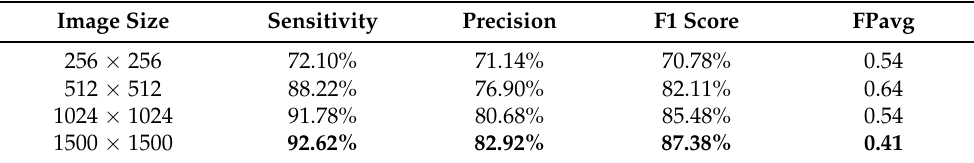
Table 5. Experiment results considering input image size. (The best result is marked in bold.)